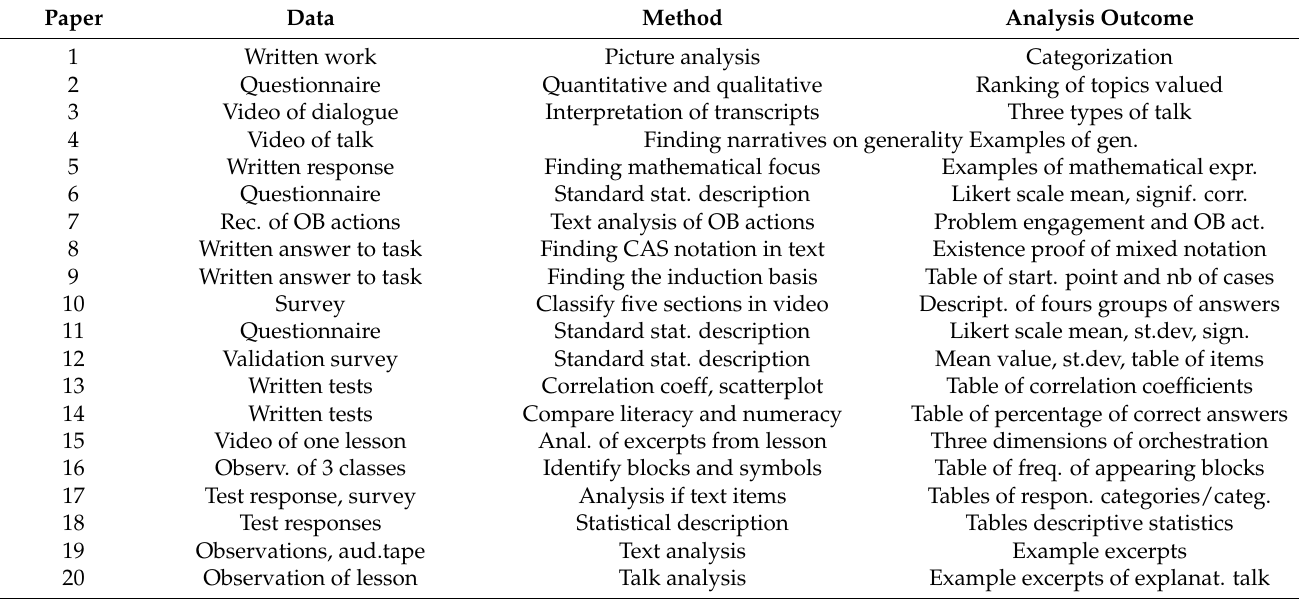
Table 6. Data, methods used, and outcome according to